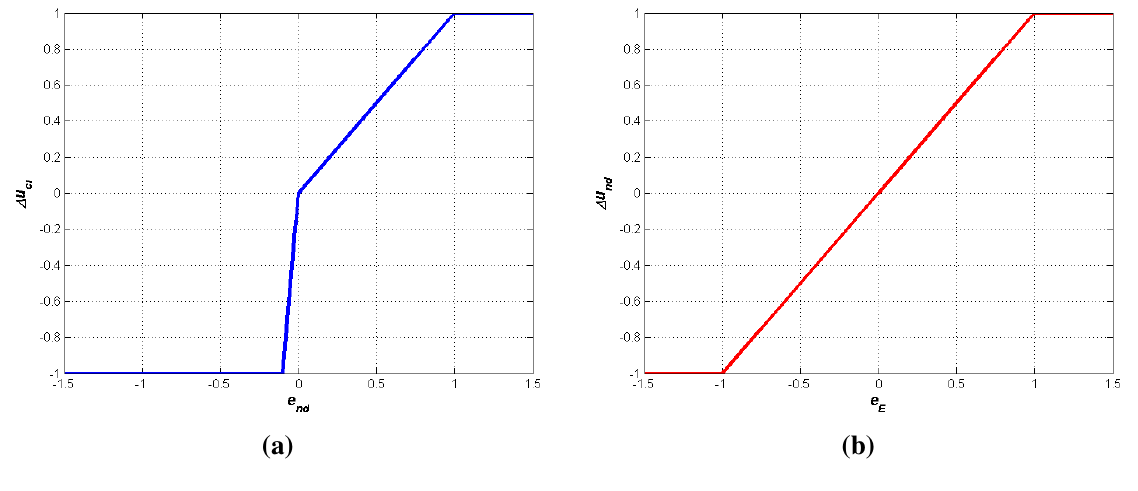
Figure 2. Fuzzy transfer functions. ( a ) FDM1; ( b )